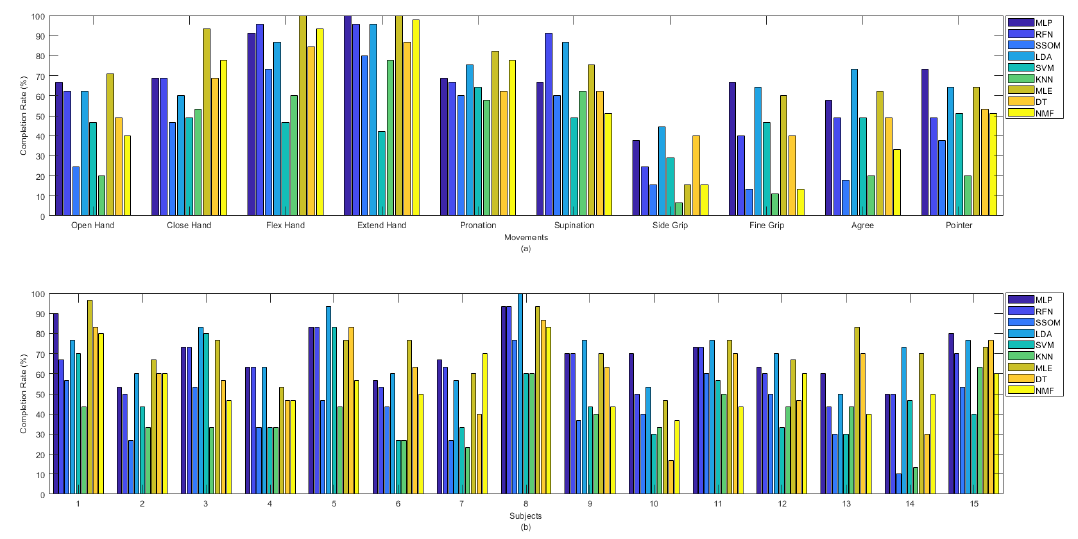
Figure 8. Completion rate between classifiers per ( a ) movements and ( b ) subjects.